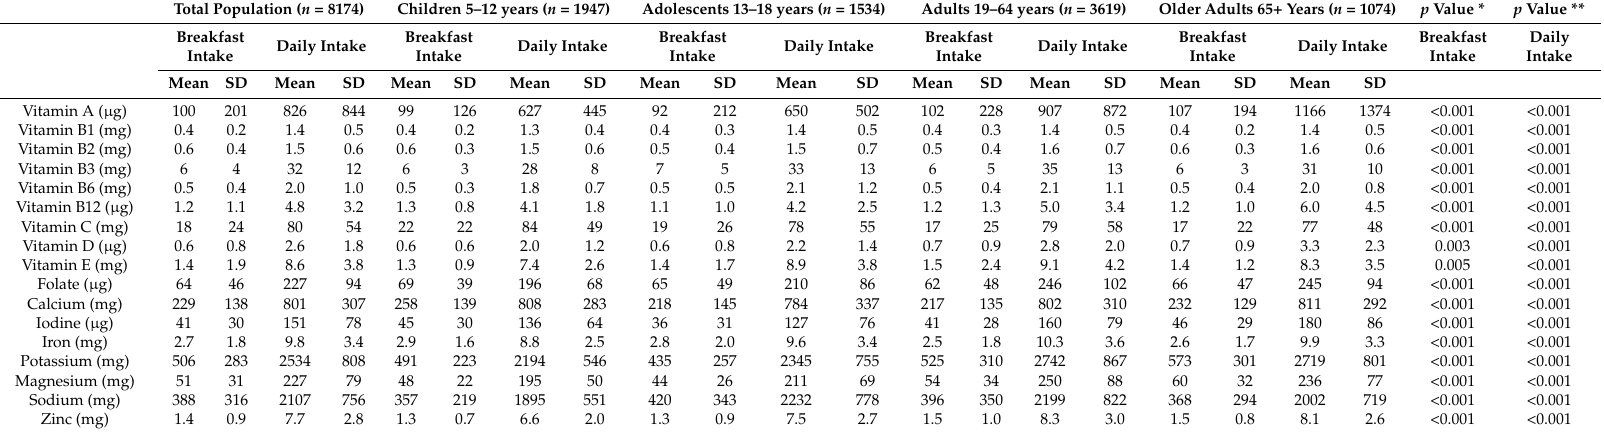
Table 2. Mean micronutrient intakes at breakfast and for the total day in the total population and by age